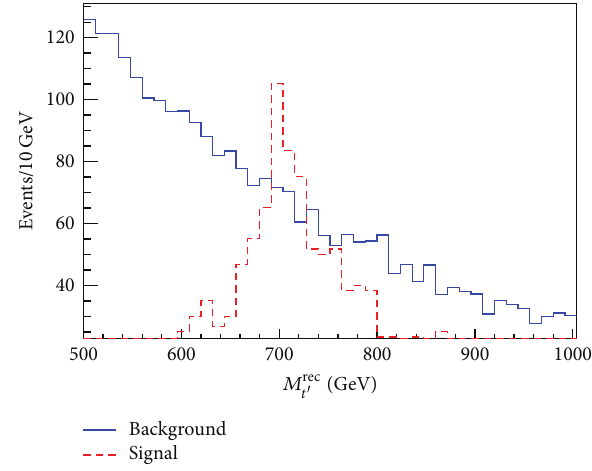
Figure 11: The reconstructed mass distributions for background and signal ( 𝑡𝛾 ) with 𝑚 𝑡 󸀠 = 700 GeV and 𝜅/Λ = 0.15 TeV −1